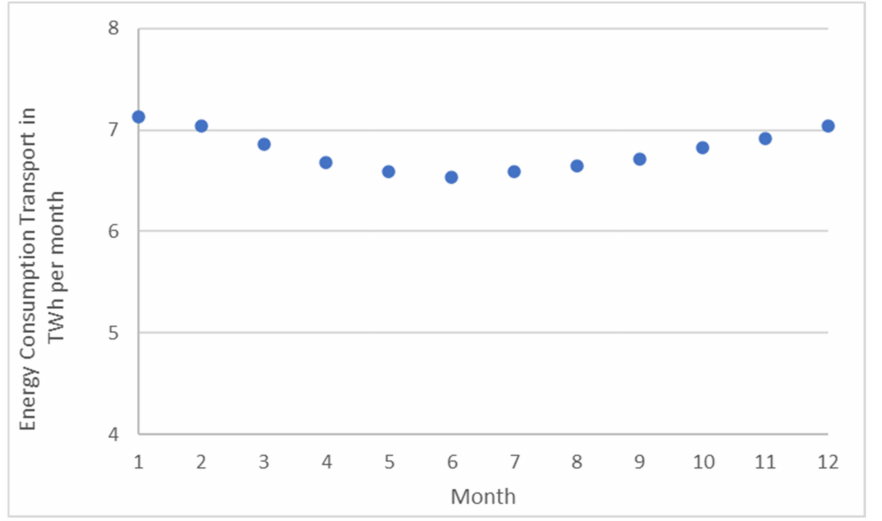
an efficiency gain of 30.7%, leads to the monthly energy consumption by transport shown in Figure 12.